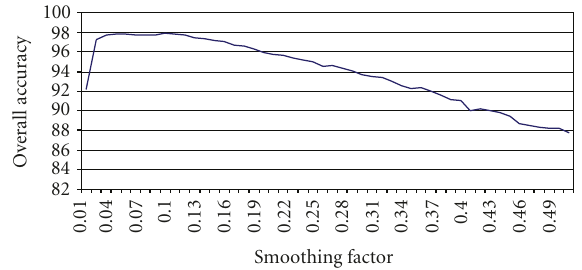
Figure 7: E ff ects of di ff erent smoothing factors in the probabilistic neural network.